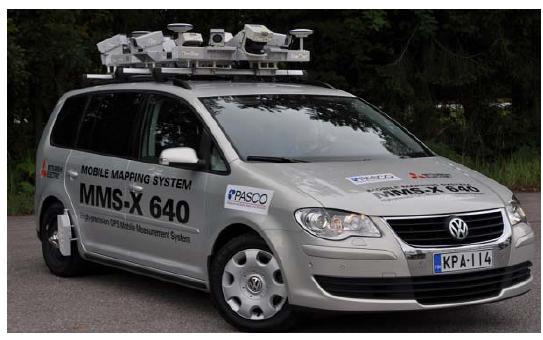
Figure 1. MELCO MMS Type-x